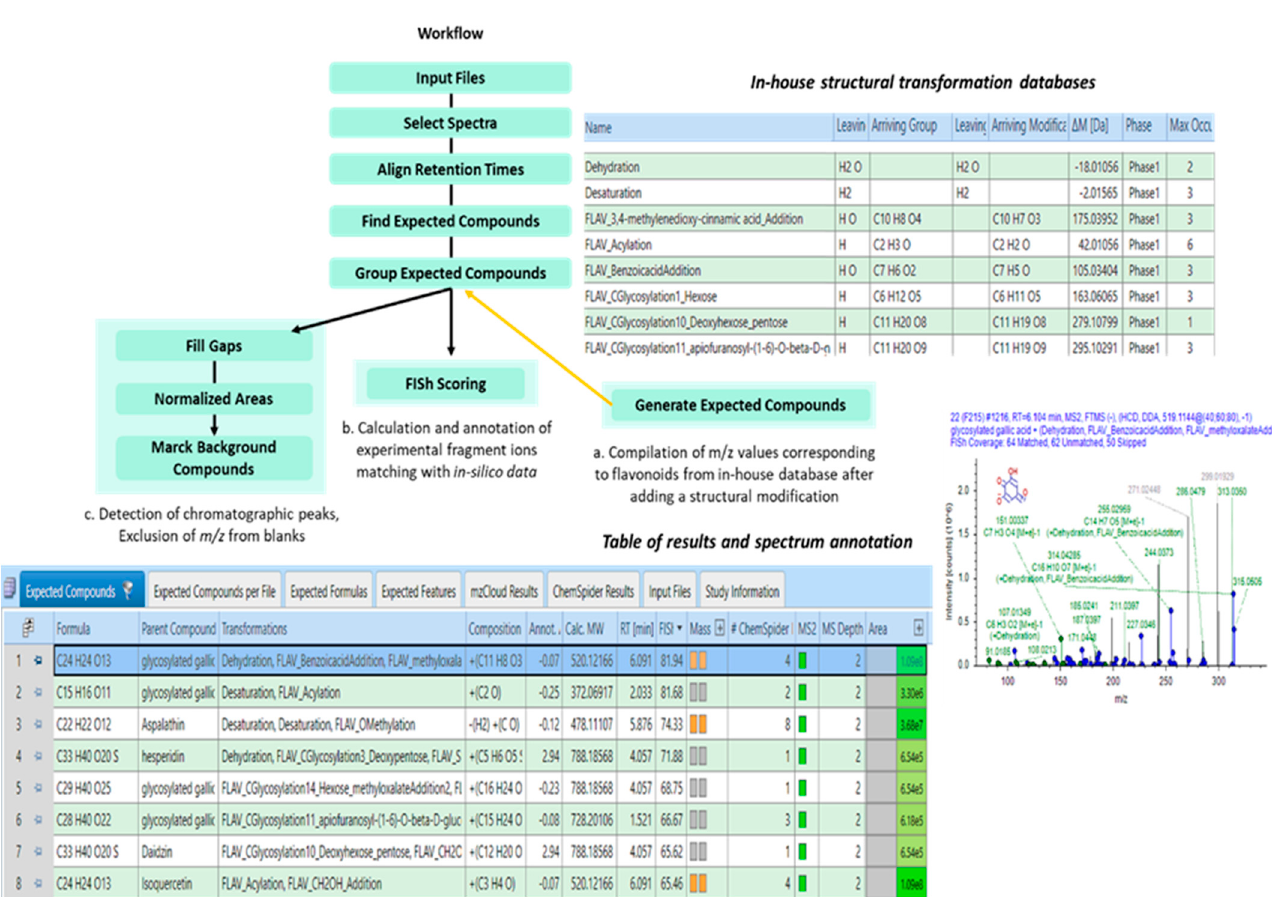
Figure 10. Flowchart of the data processing for the targeted screening of fl avonoids. Targeted